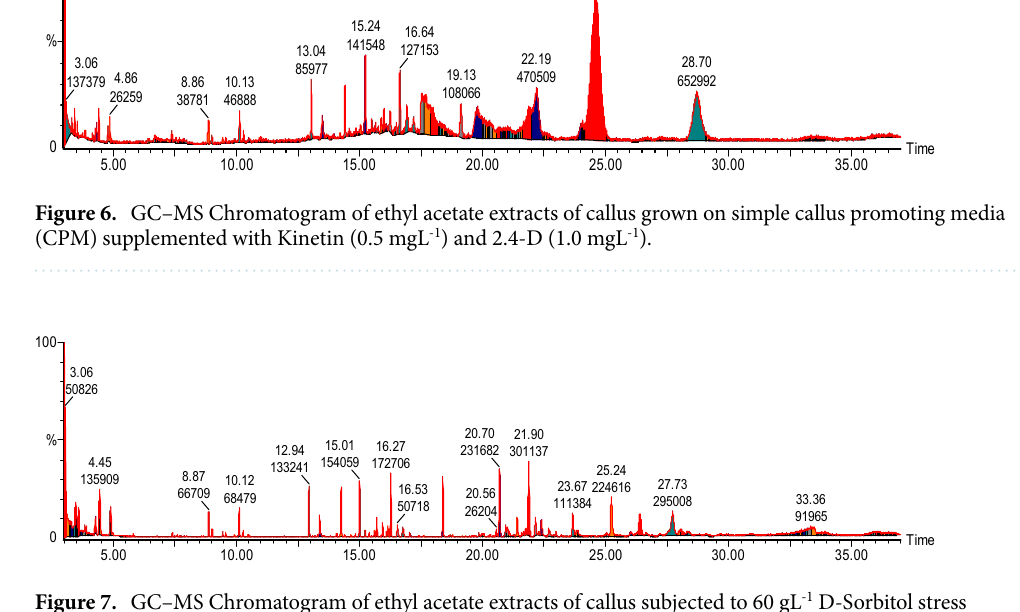
Figure 7. GC–MS Chromatogram of ethyl acetate extracts of callus subjected to 60 gL -1 D-Sorbitol stress